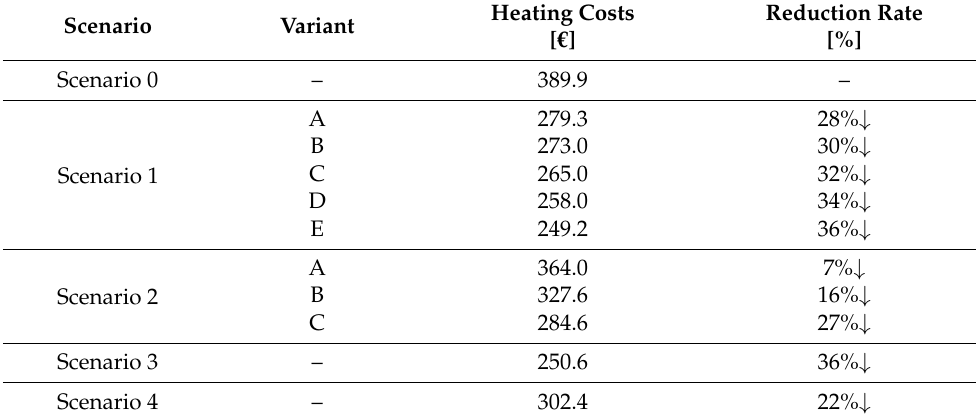
Table 5. The results of the heating costs of the building and its reduction in the adopted scenarios.